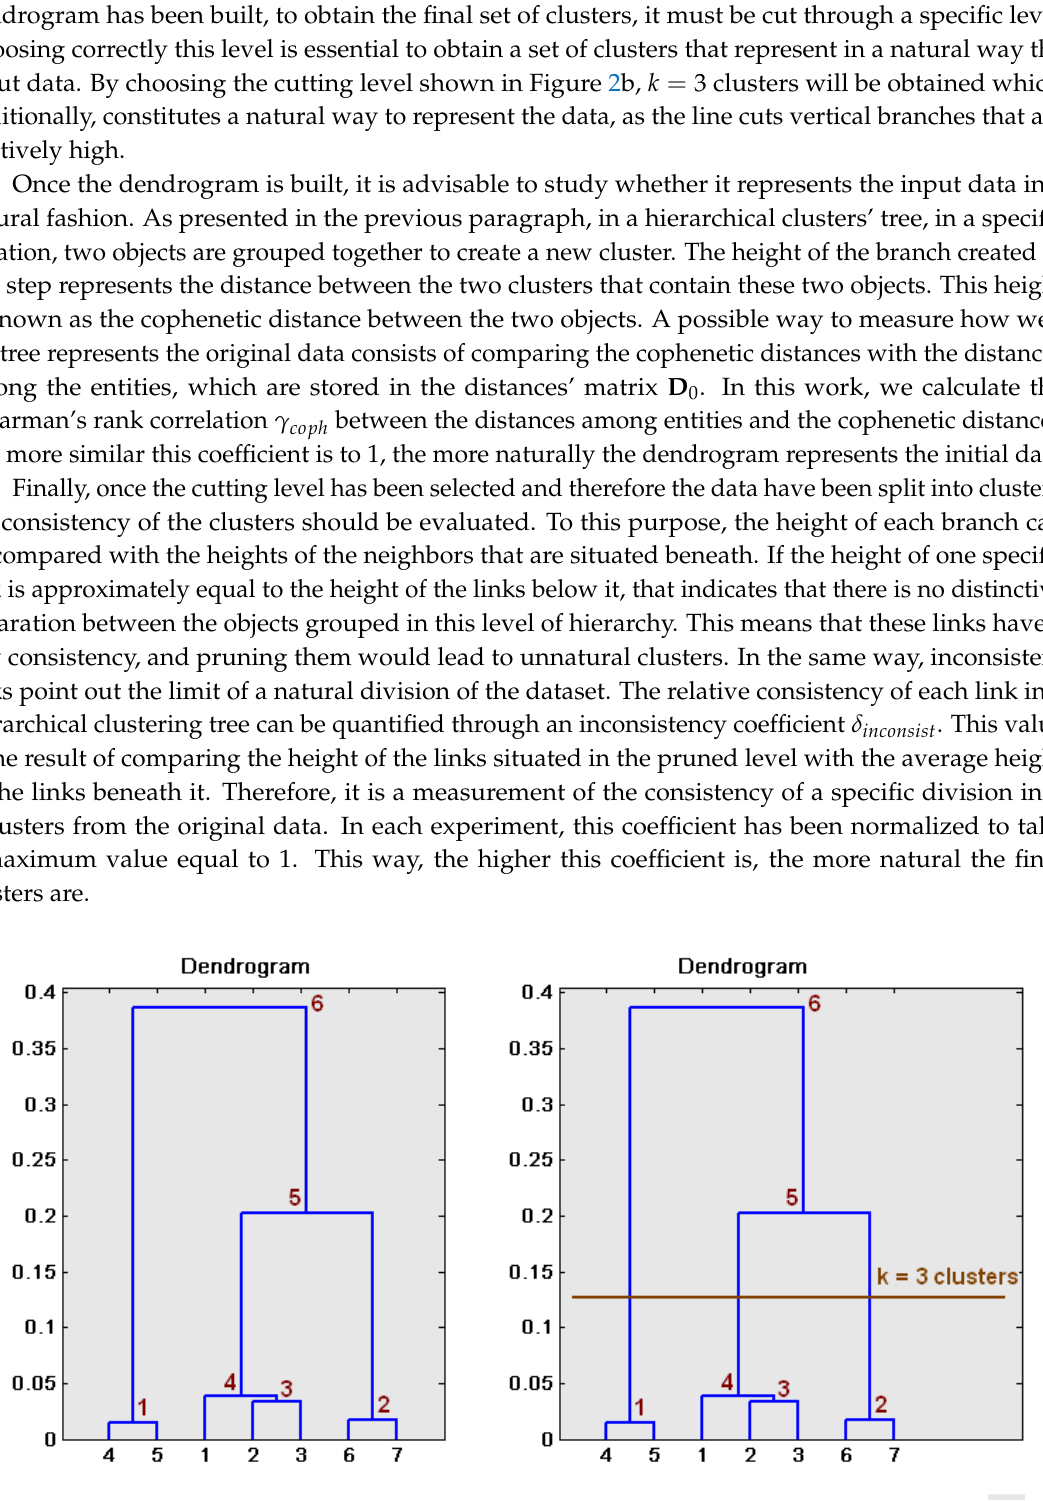
Figure 2. ( a ) Dendrogram that reflects the hierarchical clustering of the dataset G = [ (cid:126) g Pos and ( b ) cutting level that results in k = 3